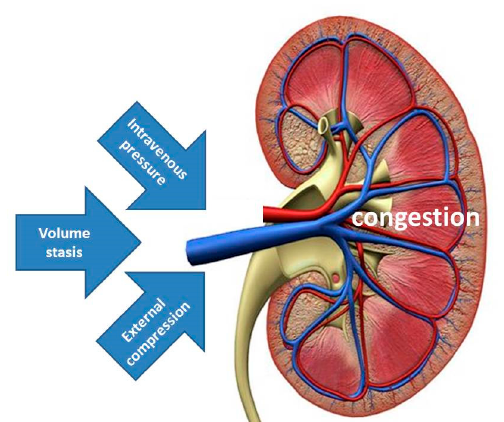
Figure 5. Illustration of the triad of venous congestion as a result of combinations of increased intravenous pressure, volume stasis and external compression. Increased intravenous pressure may be the predominant feature in EPE, volume stasis is the main trigger in the cross-over population reported by Bosio, whereas, external compression from increased intra-abdominal pressure is the leading cause in the persistently high cardiac output group reported by Easterling [16,47].